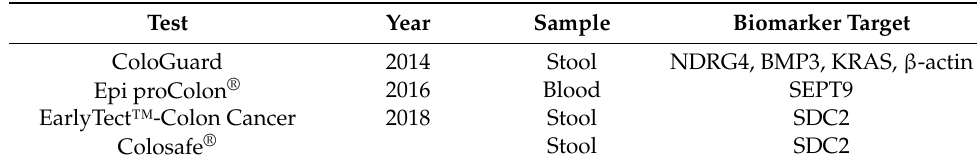
Table 1. List of approved CRC screening epigenetic biomarkers tests.